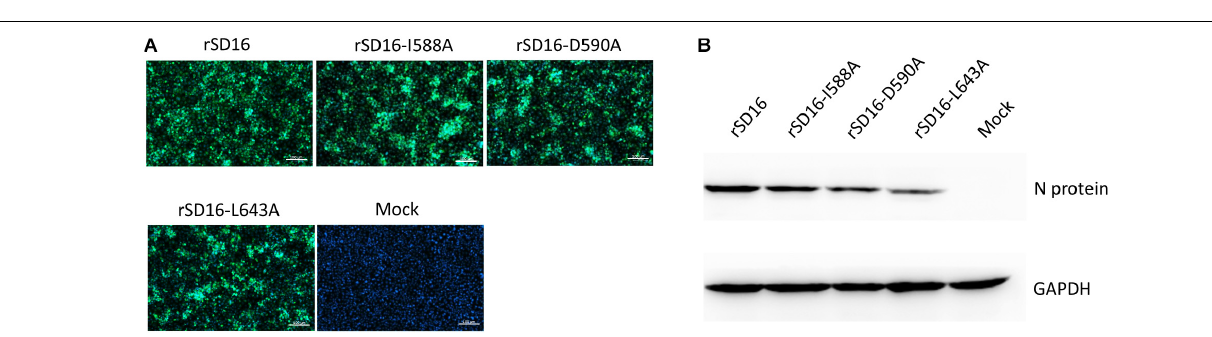
FIGURE 6 | Rescue of recombinant PRRSV bearing Nsp9 mutation. (A) MARC-145 cells transfected with DNA-launched infectious clones of wild type PRRSV-SD16 strain (rSD16) or infectious clones bearing indicated mutations in the putative interaction sites (I588A, D590A, L643A) between Nsp9 and Nb6 on rSD16 backbone. IFA were performed to detect PRRSV-N protein expression and visualized by FITC-conjugated goat anti-mouse IgG. Overlay images were visualized for cell nuclei (blue) and N protein (green) with mock-transfected cells were included as control. The scale bars are 100 µ m. (B) WB analysis of PRRSV-N protein expression in MARC-145 cells transfected with DNA-launched infectious clones of indicated mutants or wild type virus. Mock-transfected cells were used as